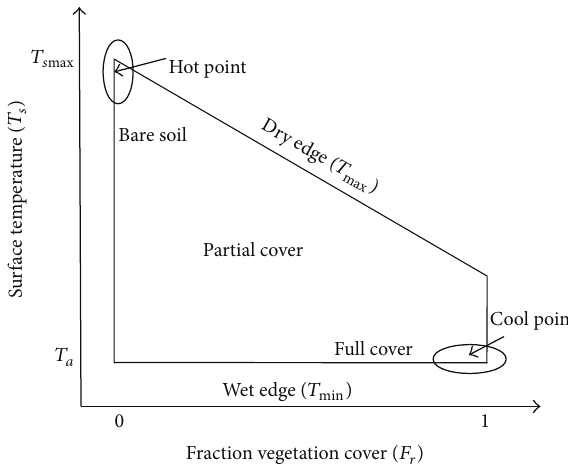
Figure 2: The schematic diagram of the conceptual surface temperature-vegetation fraction ( 𝑇 𝑠 - 𝐹 𝑟 ) triangular